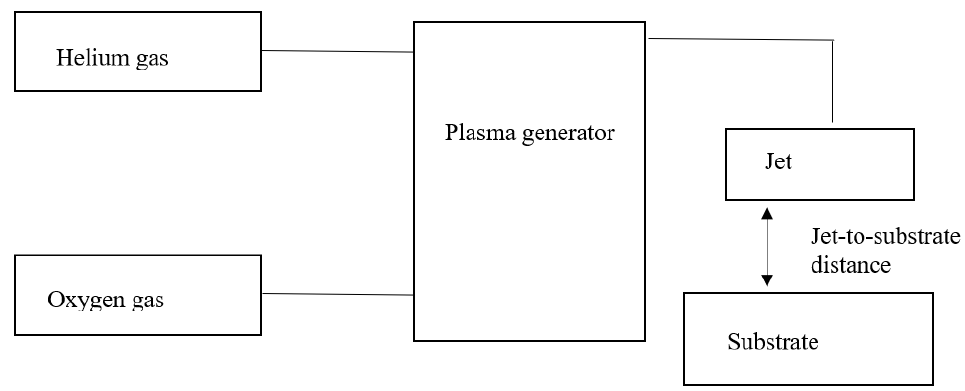
Figure 1. Schematic diagram of set-up of atmospheric pressure plasma treatment system.